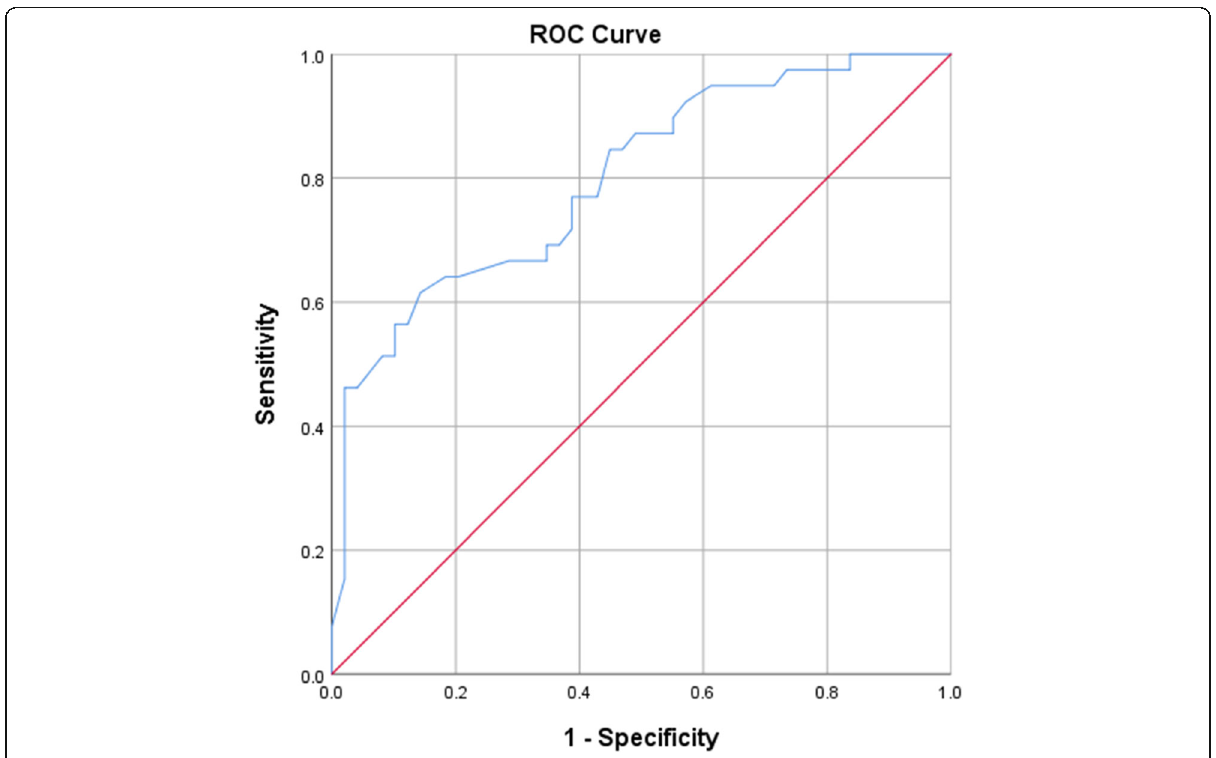
Fig. 3 ROC curve showing the ability of preoperative maximum diameter of IVC to predict hypotension after